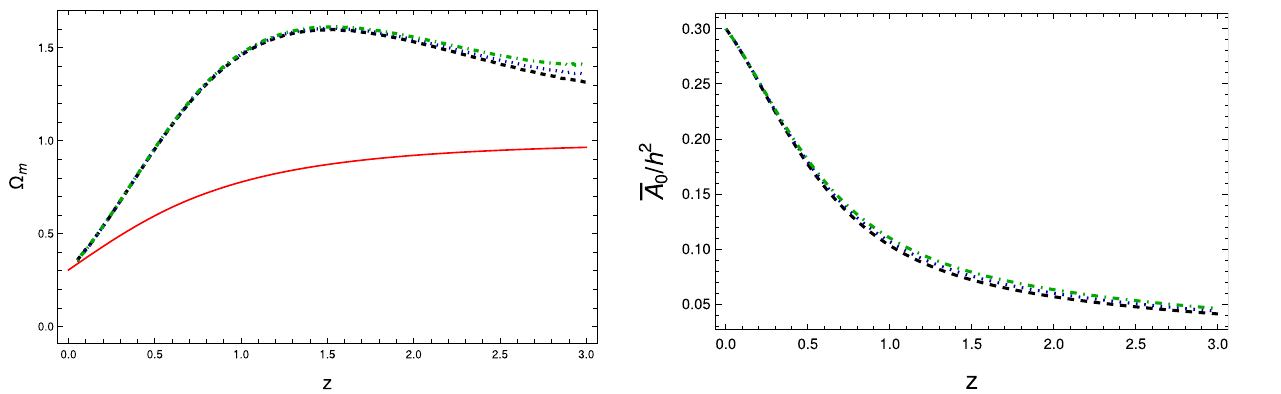
(dot-dashed), and upper 2 σ limit (dotted) of the parameters α and ¯ β in Table 1. The solid line corresponds to the (cid:2) CDM theory